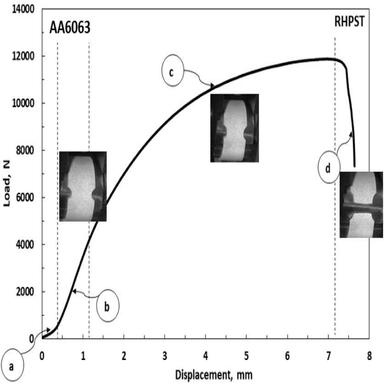
Experimental load–displacement curve of the RHPST.